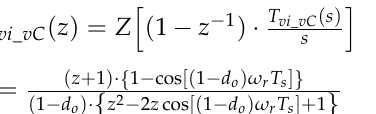
duty cycle is as high as 0.8, which corresponds to an output voltage of 400 V. Table 1. System and Control Parameter